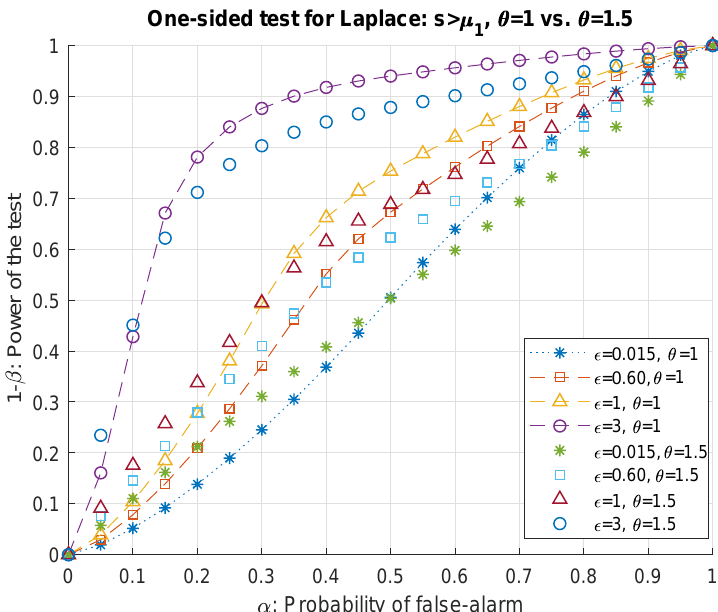
Figure 2. ROC curves for the one-sided hypothesis test ( ∆ µ = µ 1 > 0): (20) vs. (29) and (22) vs. (32) for different values of privacy parameter and s > ∆ µ where µ 0 =